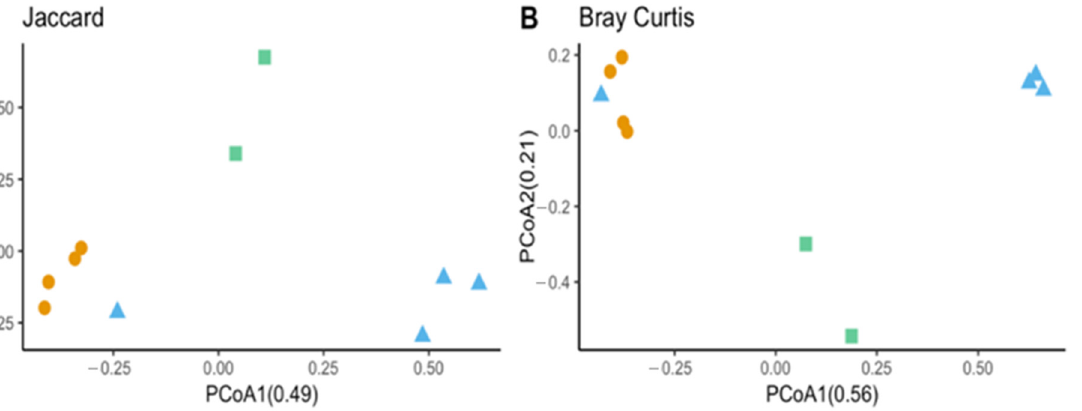
Figure 6. Beta diversity between laboratory-reared T. stercorea larva and adult gut microbiota com- position vs. field-collected adult. ( A ) Jaccard PCoA graph showing PCoA1 (0.48 variation) and PCoA2 (0.25 variation). ( B ) Bray–Curtis PCoA graph showing PCoA1 (0.56 variation) and PCoA2 (0.21 variation). ( C ) Unweighted UniFrac PCoA graph showing PCoA1 (0.48 variation) and PCoA2 (0.25 variation). ( D ) Weighted UniFrac PCoA graph showing PCoA1 (0.49 variation) and PCoA2 (0.21 variation). Blue triangles ( ▲ ) denote laboratory-reared larvae, orange circles ( ● ) denote labor- atory-reared adults, and green squares ( ■ ) denote field-collected adults. Table 2. PERMANOVA analysis based on distance matrices between laboratory-reared larvae and adults of T. stercorea gut microbiota vs. field-collected adults. Beta Diversity Measure (PERMANOVA)